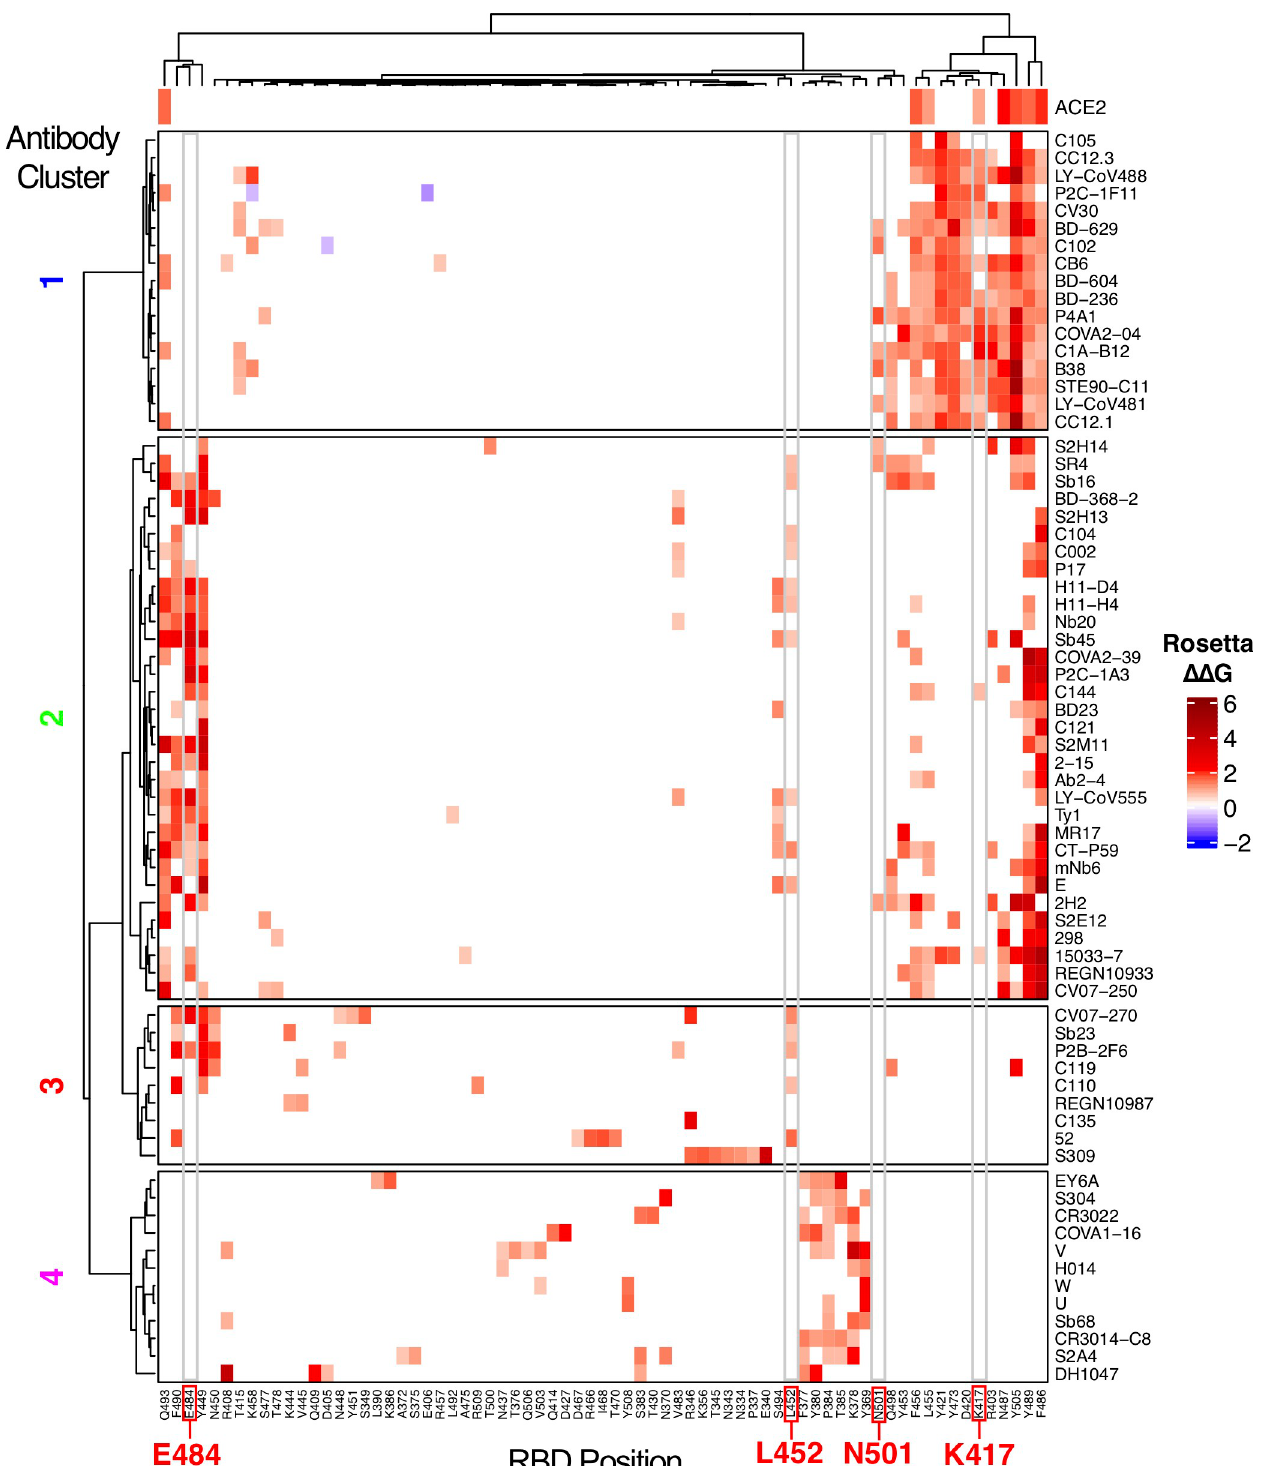
Fig 5. Computational mapping of SARS-CoV-2 RBD hotspot residues. Computational alanine scanning of RBD residues in antibody-RBD interfaces was performed using Rosetta [26], to generate binding energy change ( ΔΔ G) values for alanine substitutions at each RBD position based on modeling of residue substitutions and scoring using an energy-based function. ΔΔ G values are in Rosetta Energy Units (REU) which are comparable to energies in kcal/mol. Alanine residues in the native complex were mutated to glycine for ΔΔ G calculations, and glycine RBD residues were omitted from the analysis. In order to